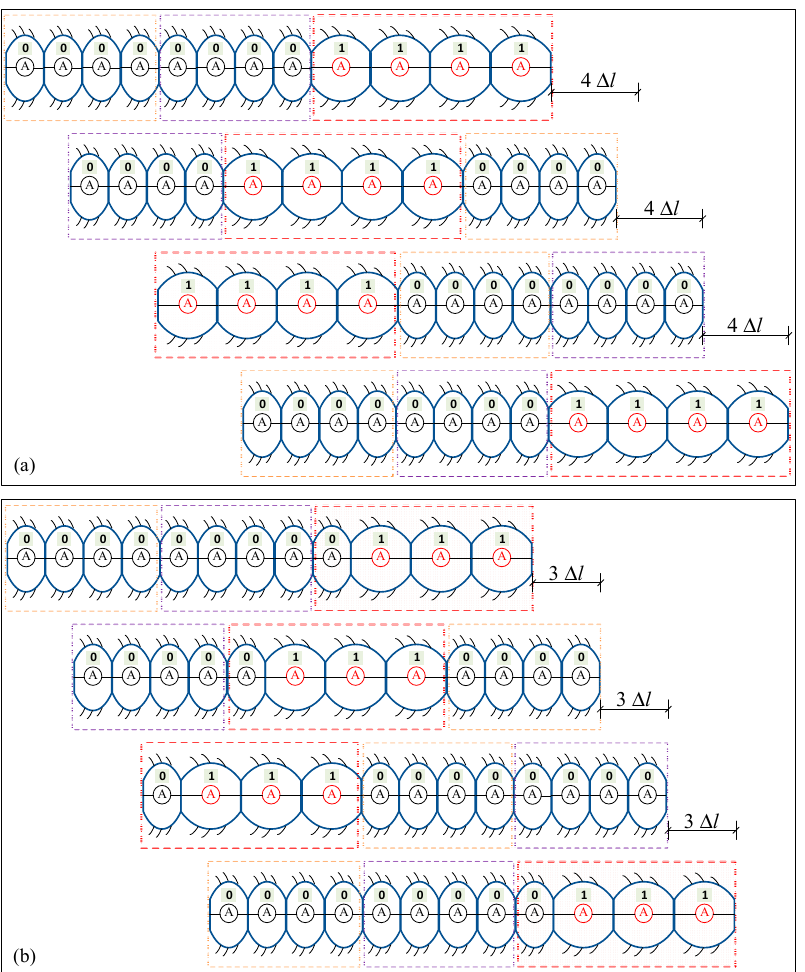
Figure 6. A gait generation demonstration for a 12-segment earthworm-like robot with two different drive modules for MG-I. A gait generation demonstration for a 12-segment robot with U-DM is shown in ( a ). The frequency of receding peristaltic wave is 1/3. The amplitude of the receding peristaltic wave is 4. A gait generation demonstration for a 12-segment robot under B-DM (“0111”) is shown in ( b ). The frequency of receding peristaltic wave is 1/3. The amplitude of the receding peristaltic wave is